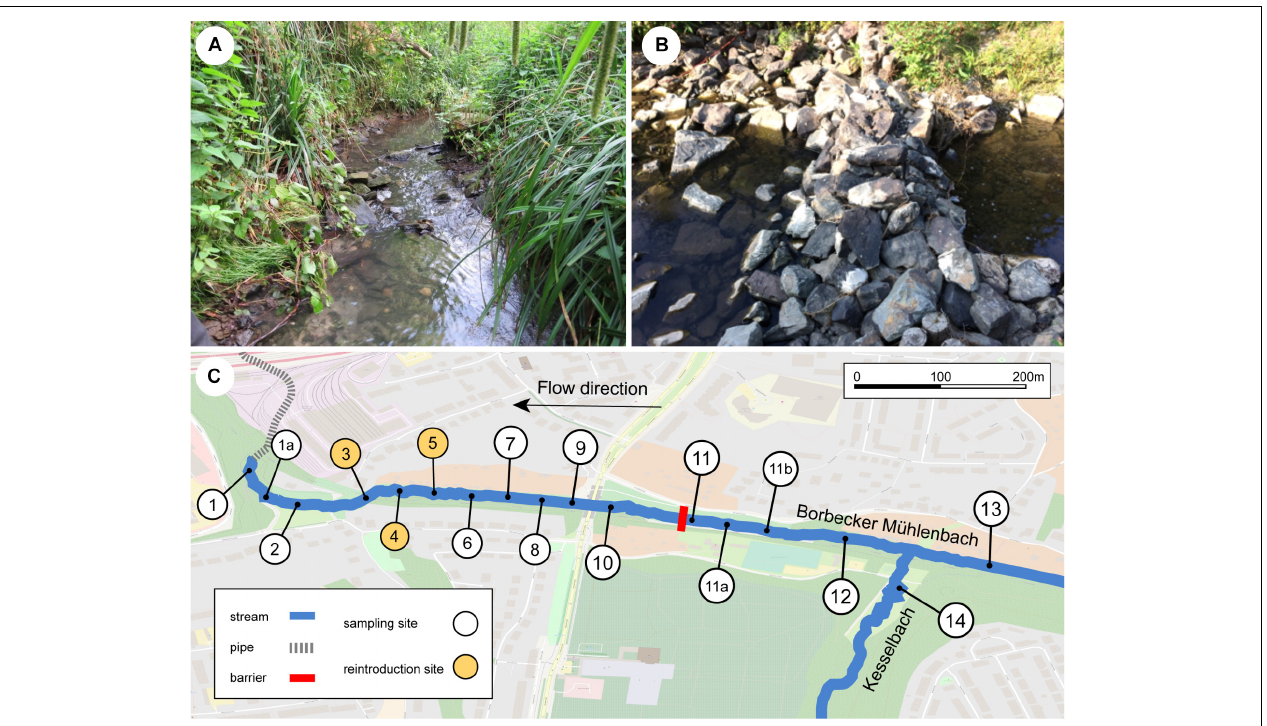
FIGURE 1 | (A) Borbecker Mühlenbach, (B) barrier downstream of site 11, which was deemed to represent a dispersal barrier for the Rhine sculpin, and (C) detailed map of the sampling sites at the stream. For coordinates of and distances between sampling sites, see Supplementary Appendix B